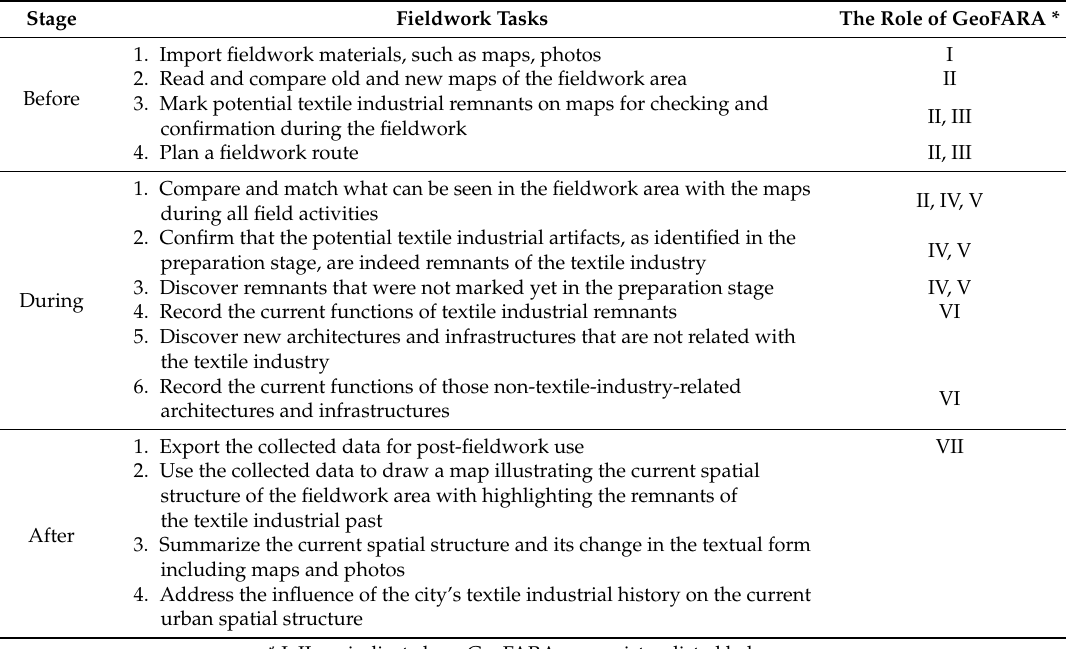
Table 3. Fieldwork tasks to be executed and how GeoFARA can